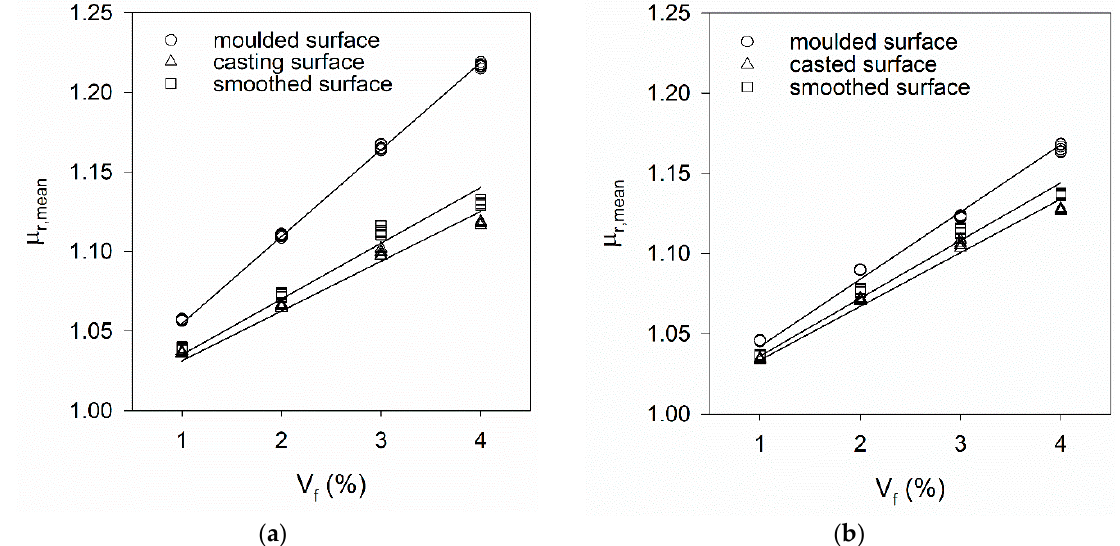
Figure 15. Increase of μ r,mean as a function of V f and corresponding fitting lines for ( a ) HR_i and ( b ) HO_i specimens.